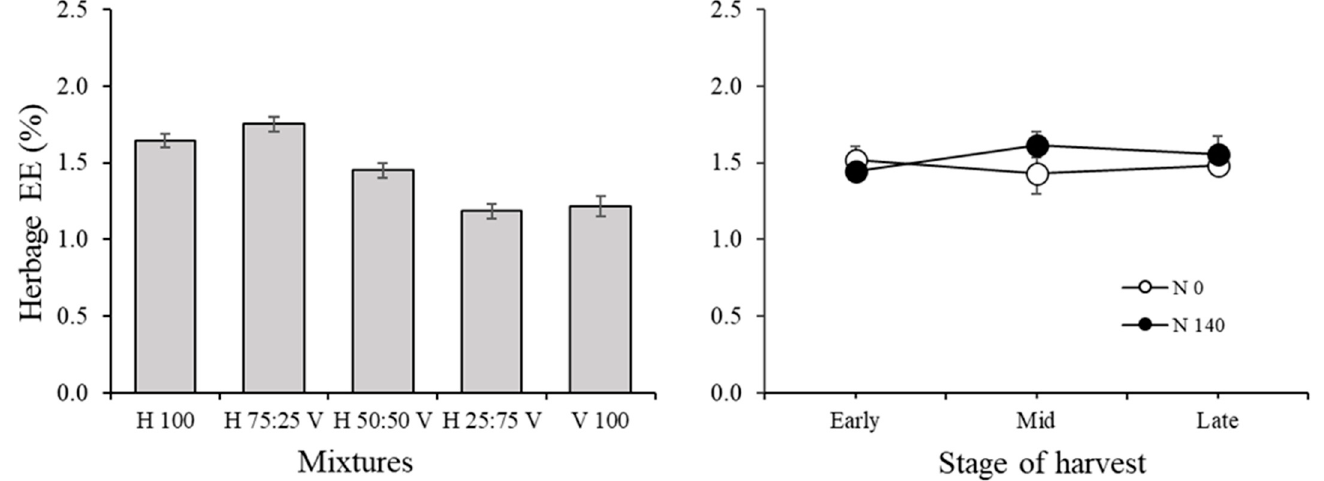
Figure 3 . Herbage EE concentration as affected by MX mean effect ( left ) and SH × NF interaction ( right ). On the left, values are LSmeans across all treatments along with standard error estimate of the LSmeans since the design was unbalanced between the faba bean crop ( n = 9) compared to the mixtures and the barley crops ( n = 18). On the right, only data of the barley-containing treatments were used. Each point represents the arithmetic mean ( n = 24) and its computed standard error.